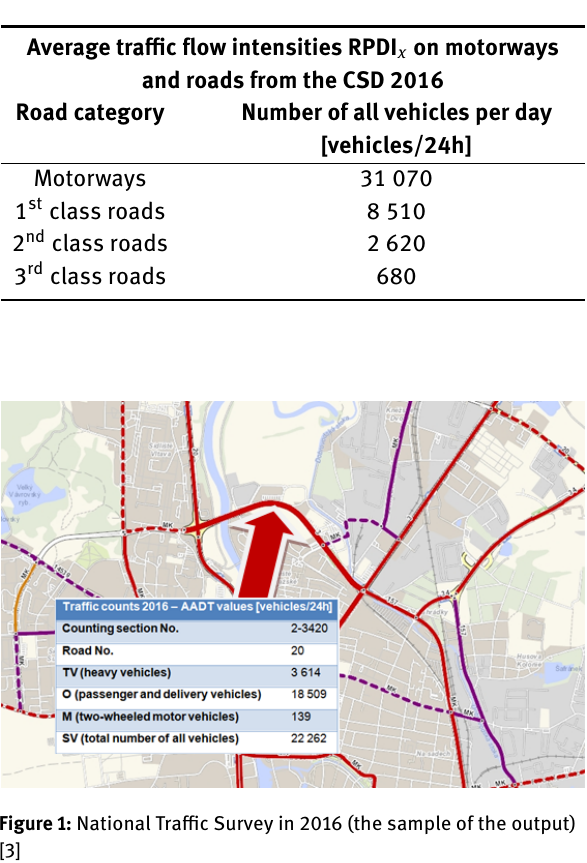
Table 1: Table of average traflc flow intensities from the CSD 2016